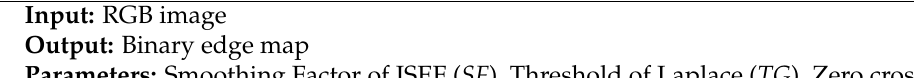
Algorithm 6 Shen–Castan Operator